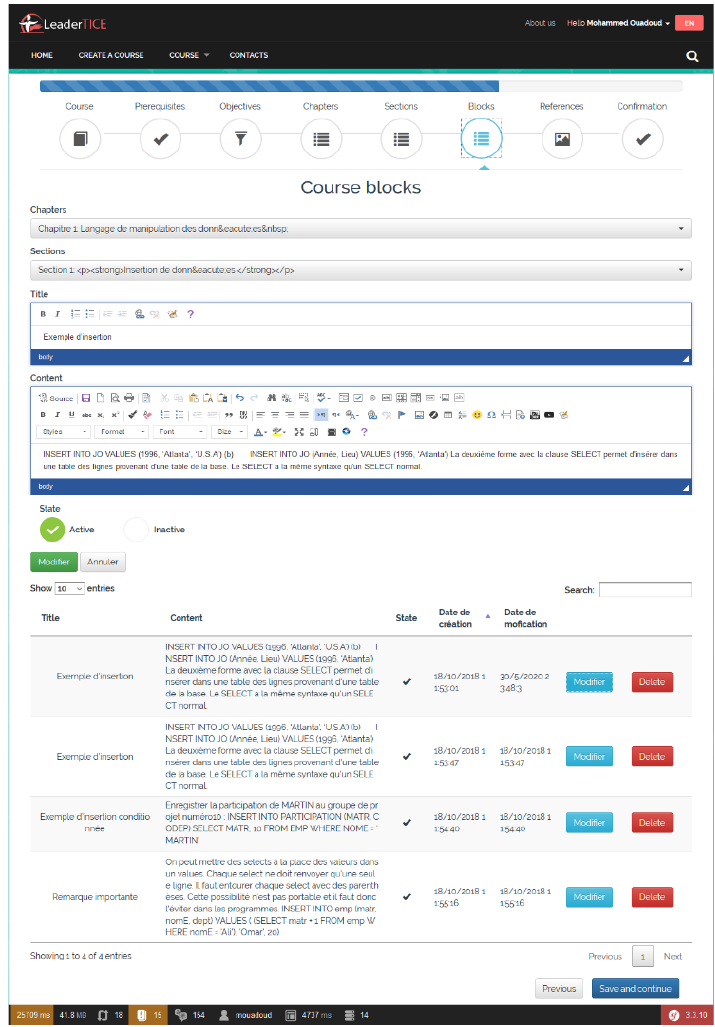
Fig. 8. Course blocs interface developed by the NoSQL MongoDB